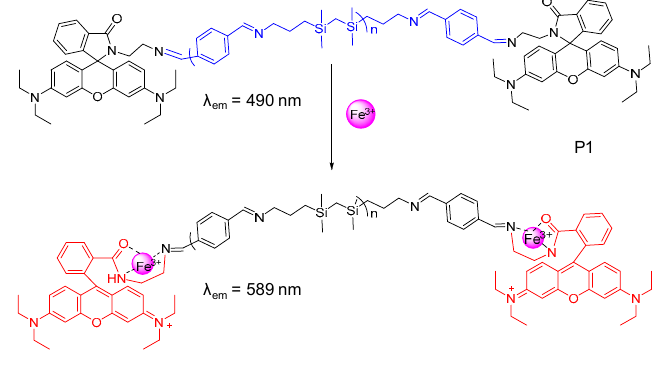
Figure 6. The ratiometric response mechanism of P1 to Fe 3+ [47].